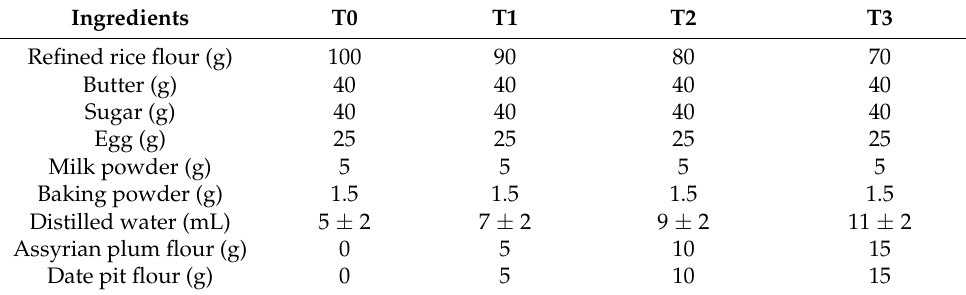
Table 1. Formulations of gluten-free biscuit